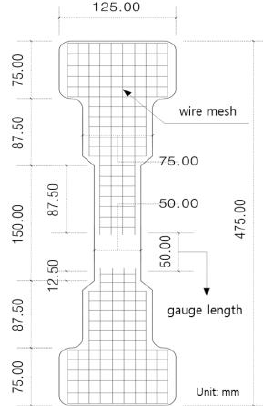
Figure 1. Schematic of the specimen. Materials 2019 , 12 , x FOR PEER REVIEW